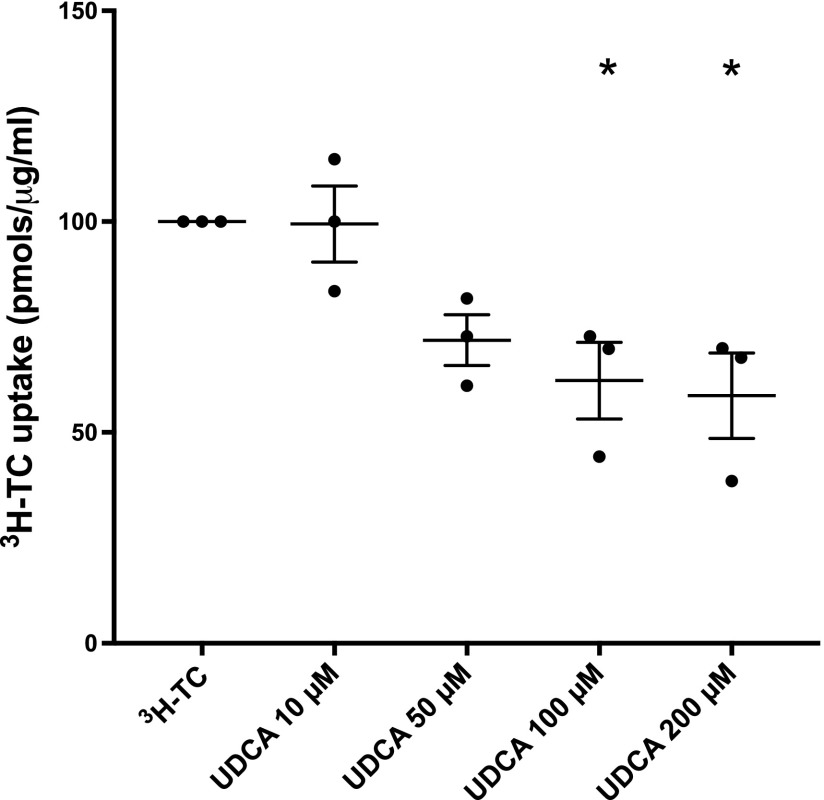
UDCA inhibits TC uptake in placental villous fragments in a dose-dependent manner. Compared with 3H-TC alone, 100–200 μM UDCA inhibited TC uptake (*P < 0.05, n = 3 placentas, triplicate conditions, 3 fragments/replicate). Data are presented as means and sem and were analyzed by a 1-way ANOVA with Dunnett’s post hoc (compared with 3H-TC alone).